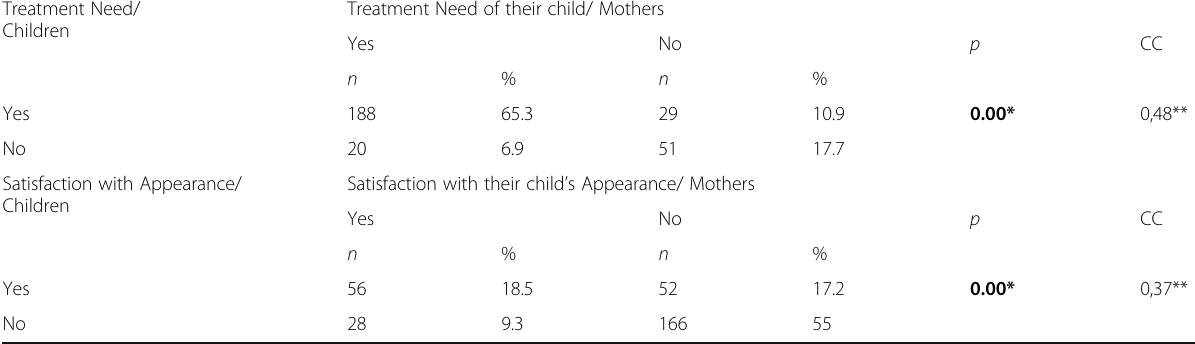
Table 4 Association of perceived of treatment need and satisfaction with appearance between children and their mothers Treatment Need/